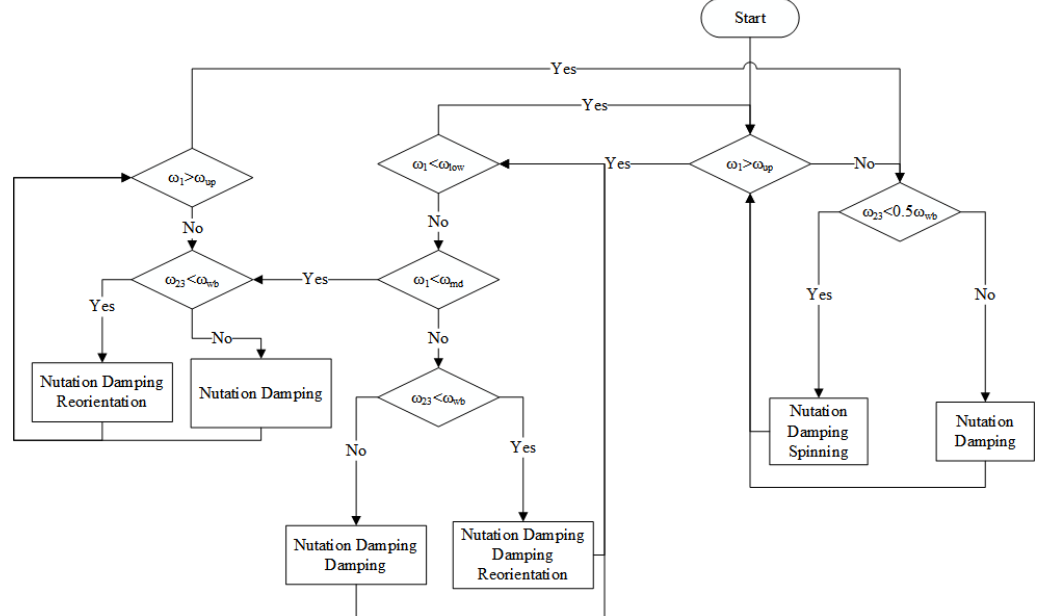
Figure 3. Control switching logic.